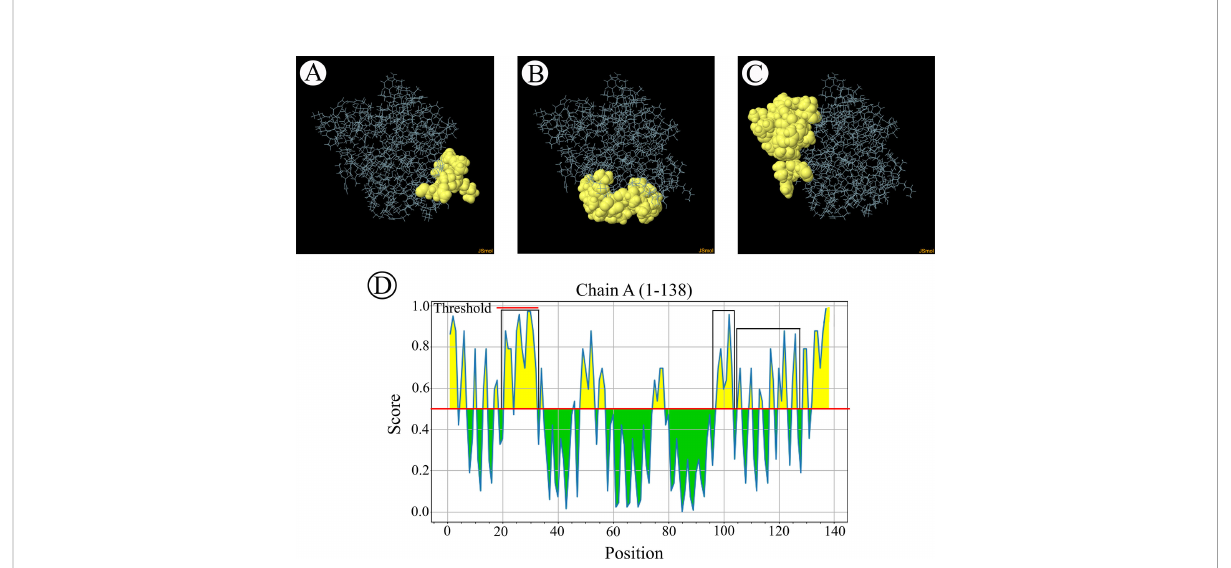
FIGURE 8 The predicted discontinuous B-cell epitopes based on the 3D structure of B bigemina rap-1a protein (A – C) displayed the overlapping region in the same position as the B-cell linear structure prediction (D)